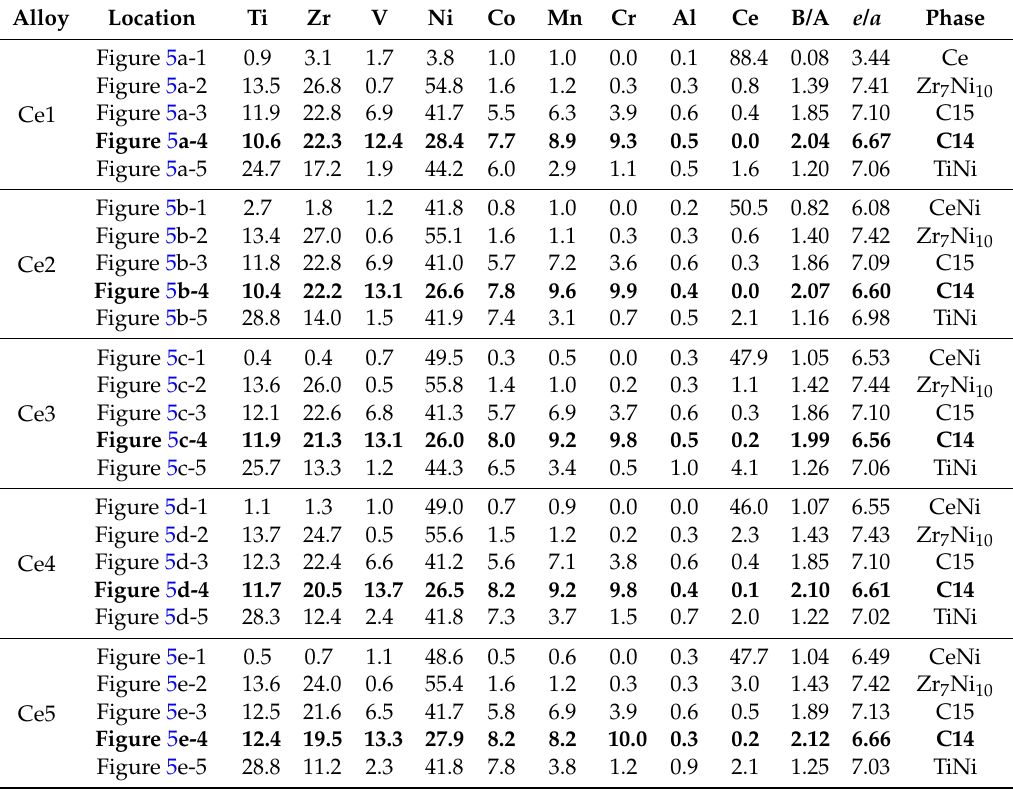
Table 4. Summary of the energy dispersive spectroscopy (EDS) results from several selective spots in the SEM-BEI micrographs shown in Figure 5. All compositions are in at%. The main C14 phase is identified in bold